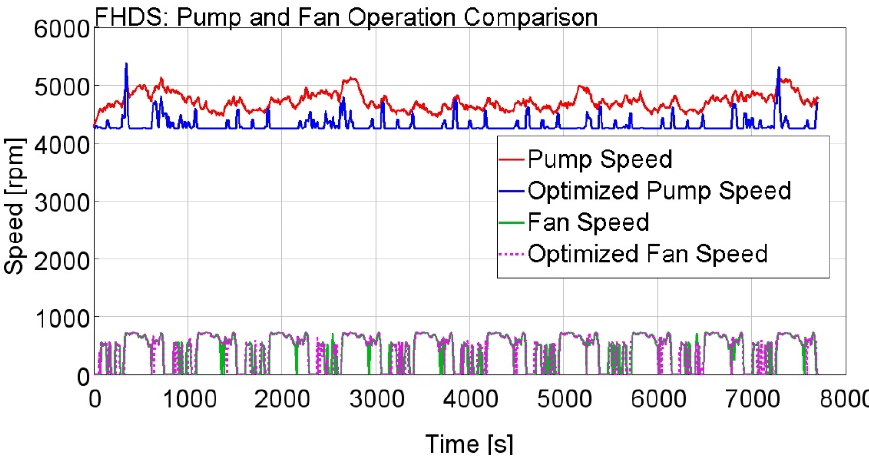
Figure 20. Control strategy comparison for dual IDM on FHDS driving cycle: coolant pump speed (top); radiator fan speed (bottom).